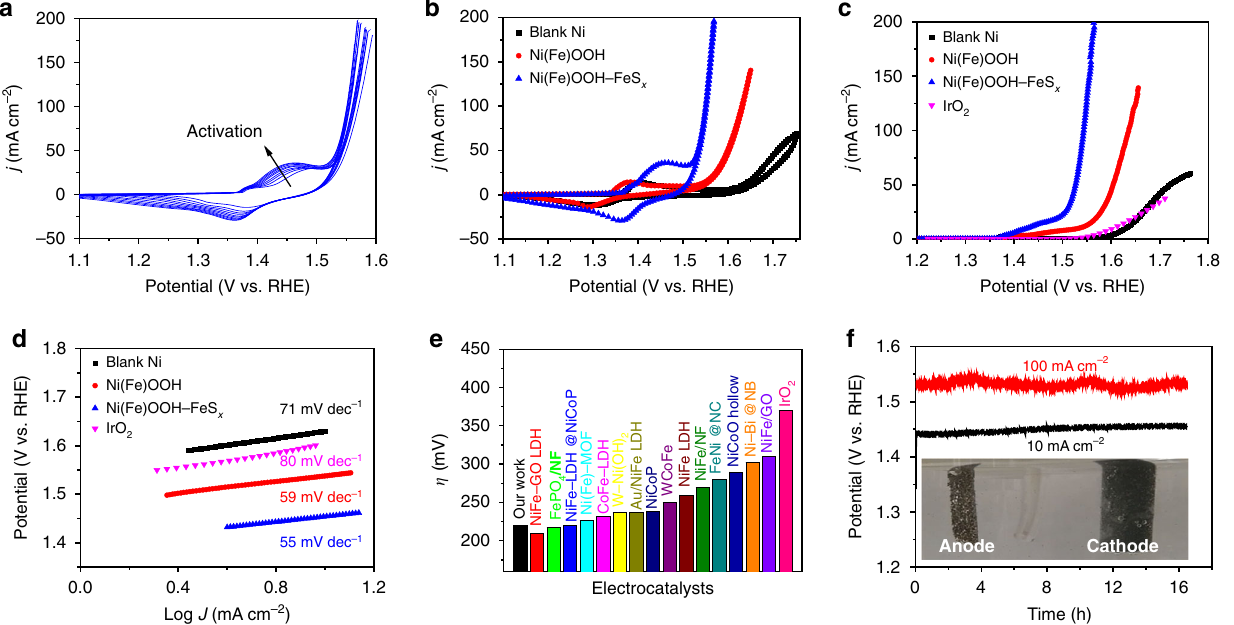
Fig. 5 Electrochemical measurements of different electrodes. a Activation CV curves of Ni(Fe)OOH – FeS x . b CV pro fi les, c polarization curves, and d the corresponding Tafel plots of different electrodes, e activity comparison of recent NiFe-based electrocatalysts. f Chronopotentiometric curves of Ni(Fe) OOH – FeS x obtained at the constant current densities of 10 and 100 mA cm – 2 (inset shows the three electrodes